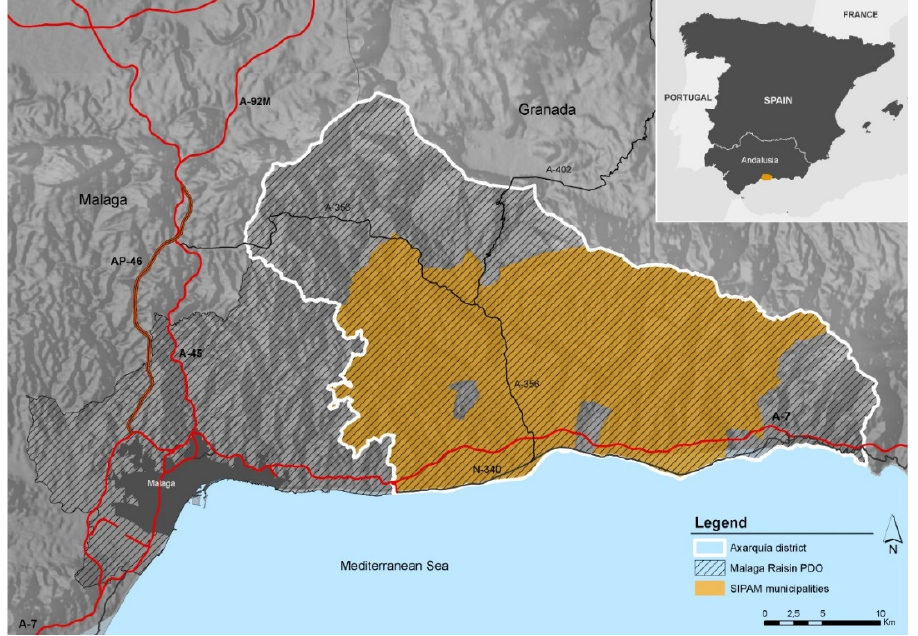
Figure 4. Location of Axarquía supramunicipal district. Source: Prepared by authors.